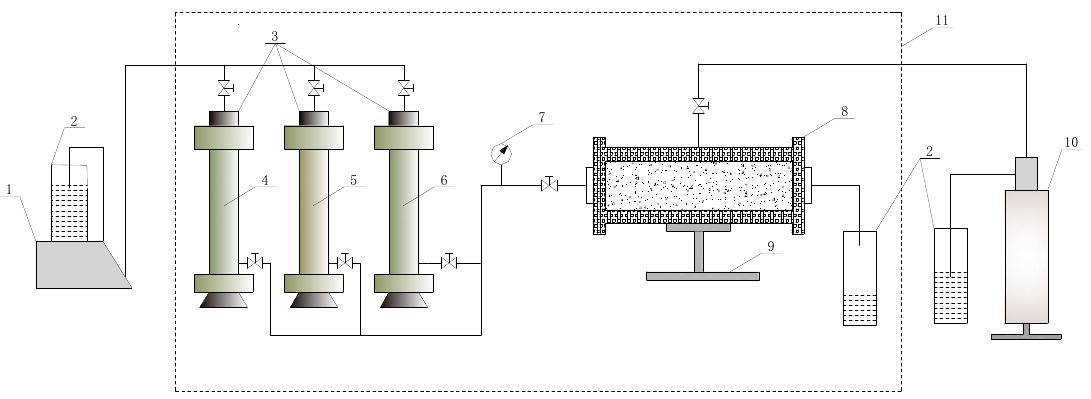
Figure 8. Diagram of the experimental process. 1-plunger pump; 2-beaker; 3-container; 4-water; 5-polymer; 6-ASP solution; 7-pump sensor; 8-core holder; 9-base; 10-manual pump; 11-oven.